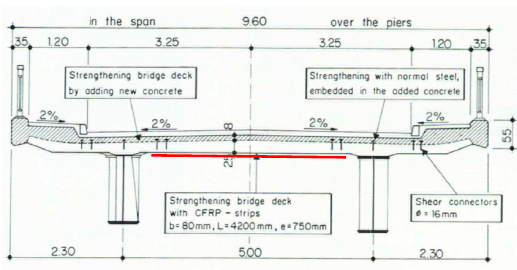
Figure 21. Cross-section of the bridge. Figure taken from [35]. The location of the CFRP strips are indicated with a red line.